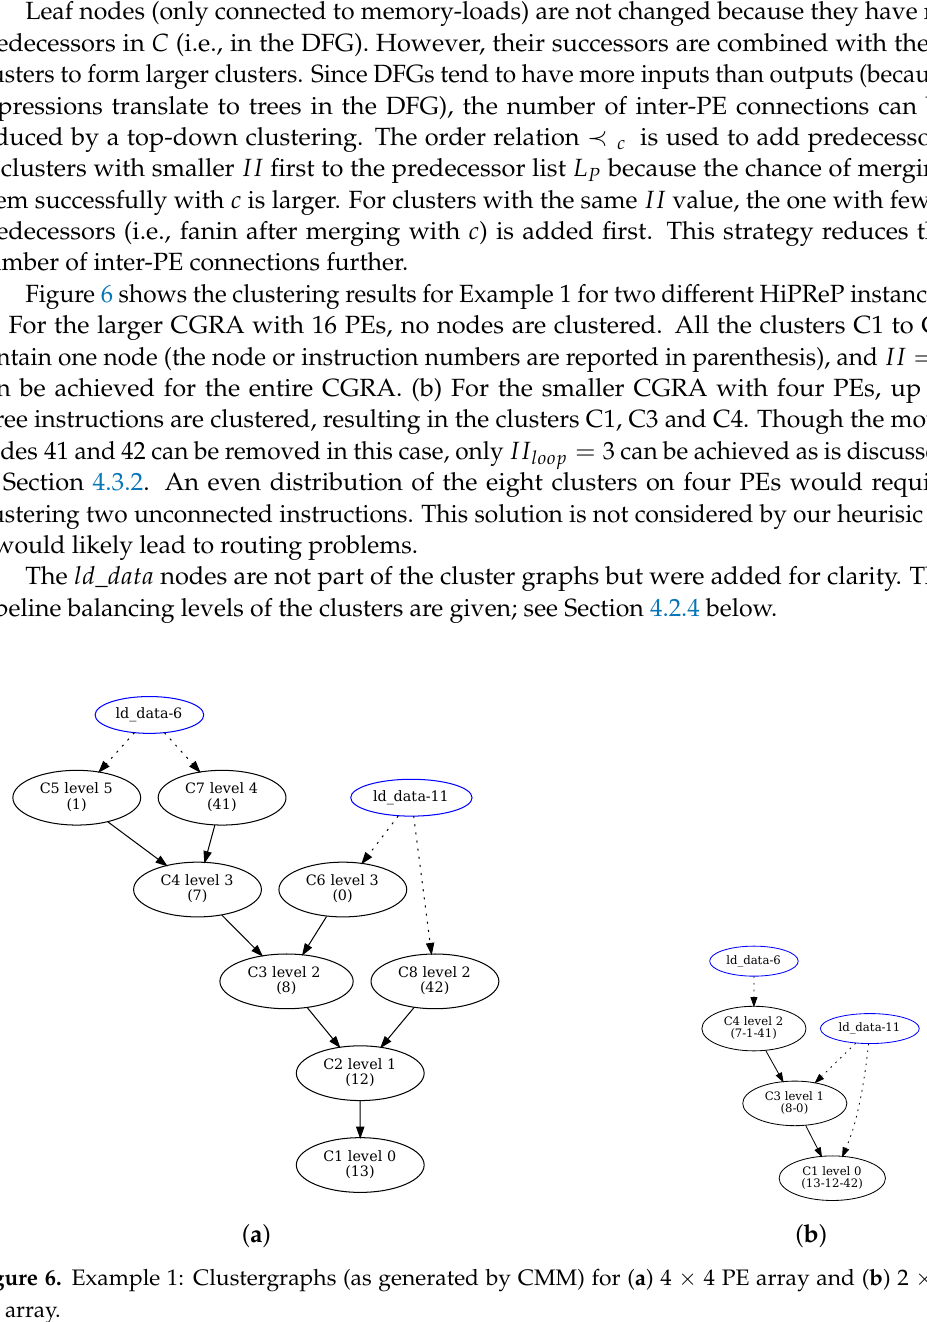
Figure 6. Example 1: Clustergraphs (as generated by CMM) for ( a ) 4 PE